Question: Which visualization type does this figure use?
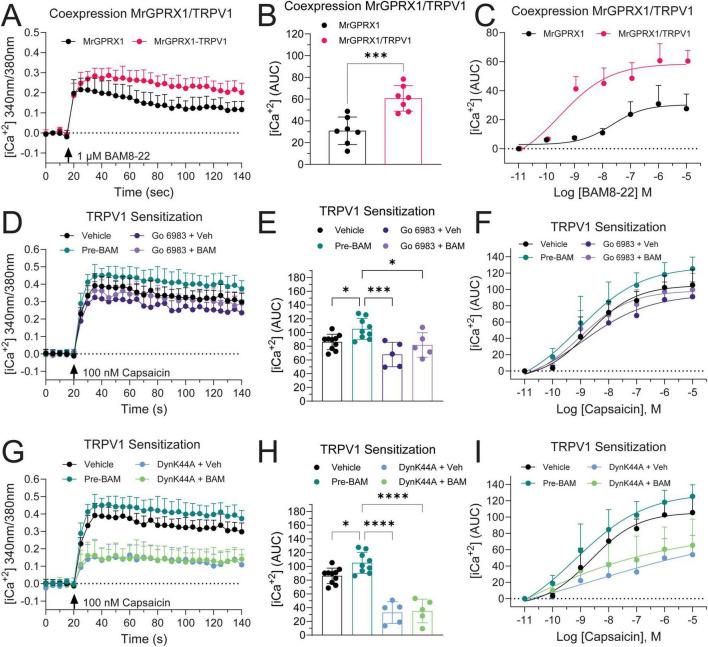
Answer: line